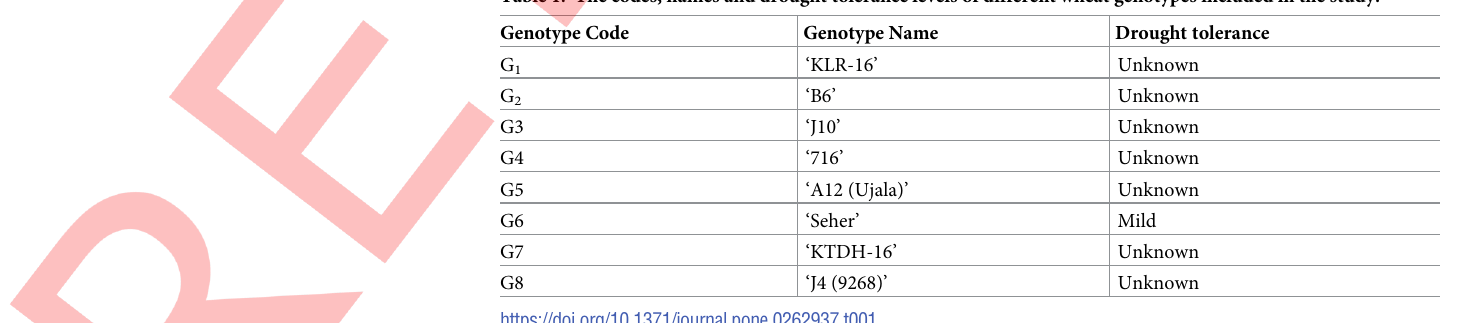
Table 1. The codes, names and drought tolerance levels of different wheat genotypes included in the